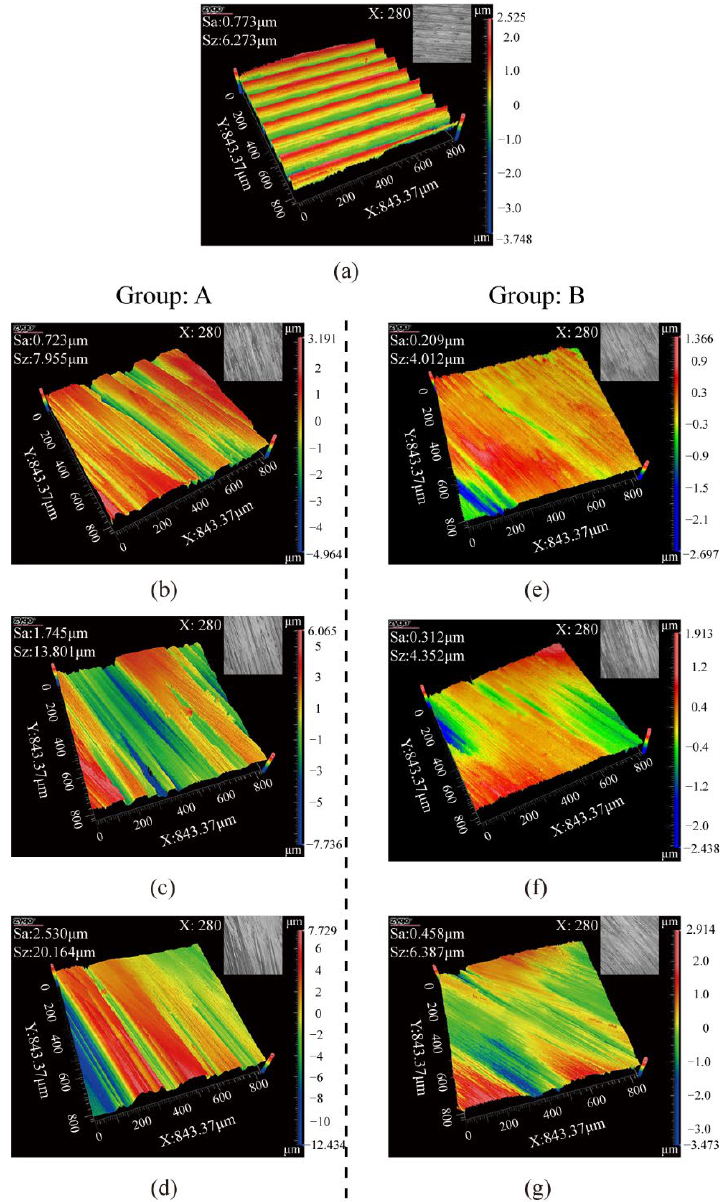
Figure 8. 3D profile of rail sample surfaces: ( a ) before grinding; ( b ) 30 s first grinding (A 1 ); ( c ) 30 s second grinding (A 2 ); ( d ) 30 s third grinding (A 3 ); ( e ) 10 s first grinding (B 1 ); ( f ) 10 s second grinding (B 2 ); ( g ) 10 s third grinding (B 3 ).